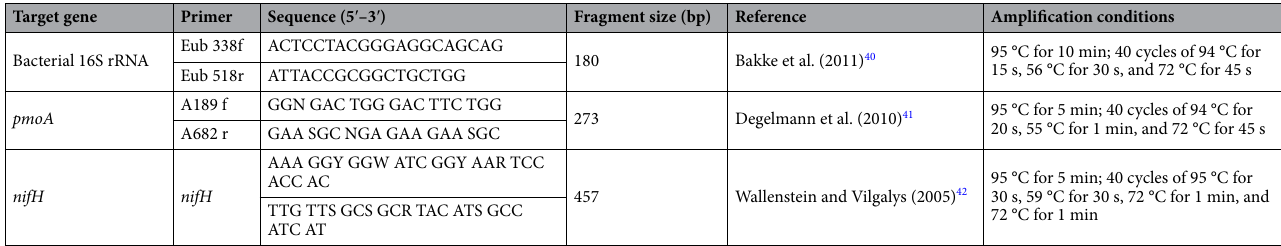
Table 1. Primers used for the amplification of bacterial 16S rRNA, pmo A, and nif H